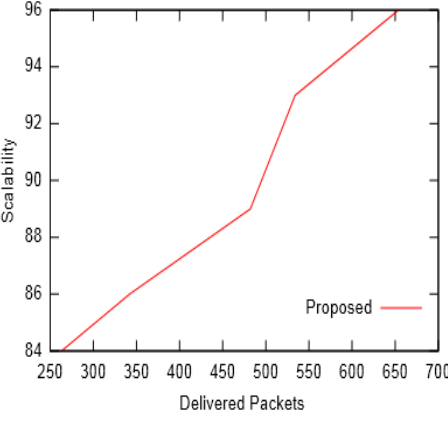
Figure 9. Data Packets Delivered for 100